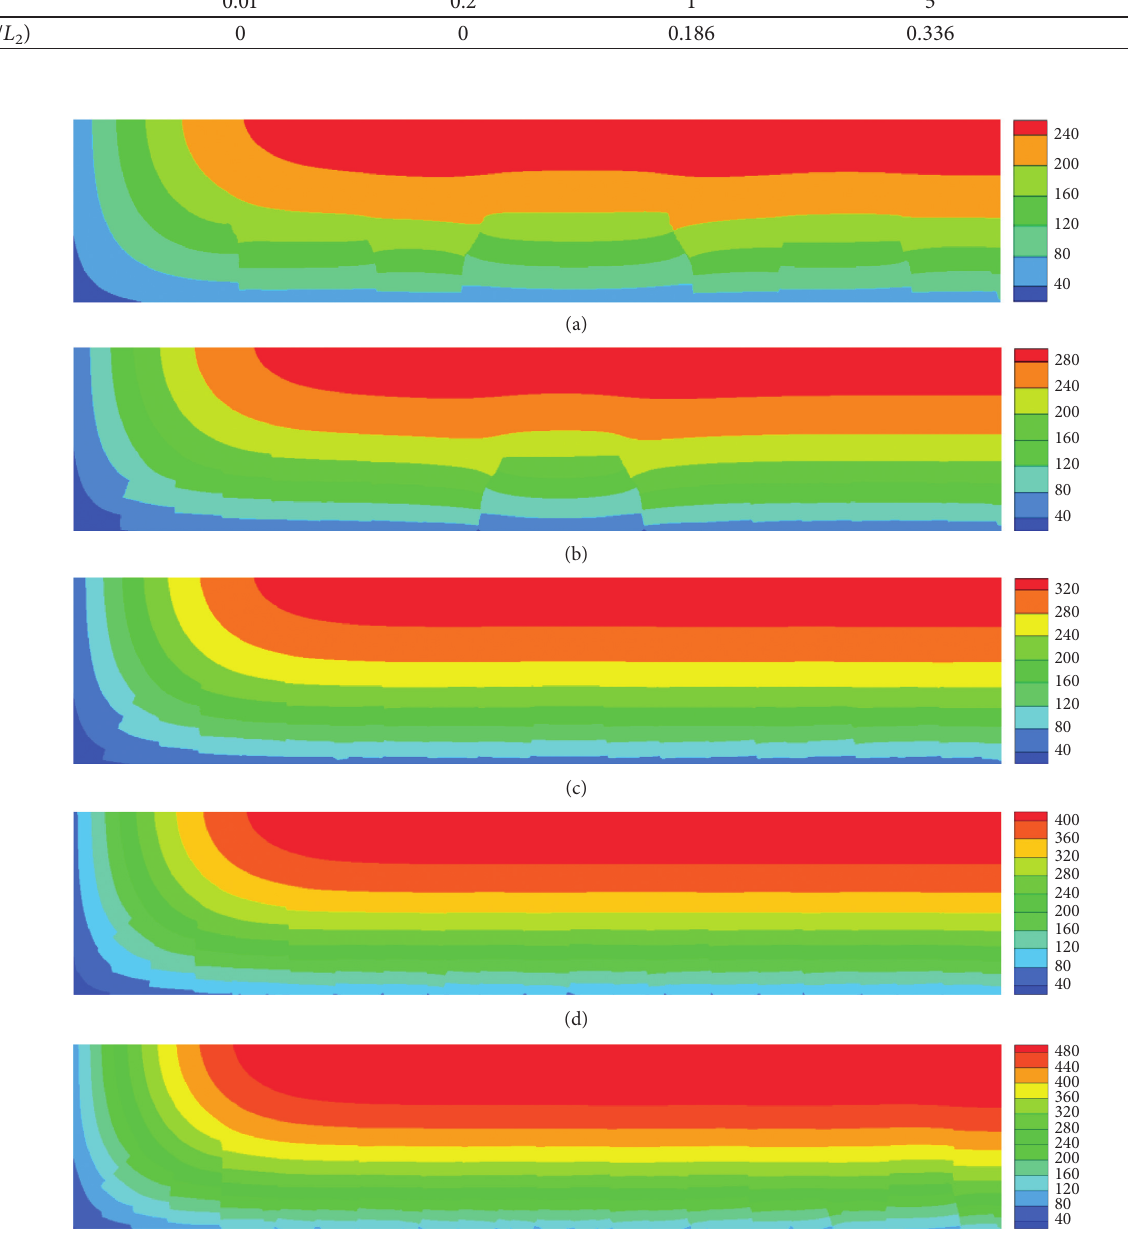
� 300 ° C; (b) T � 350 ° C; (c) T � 400 ° C; (d) T � 500 ° C; 0 0 0 0